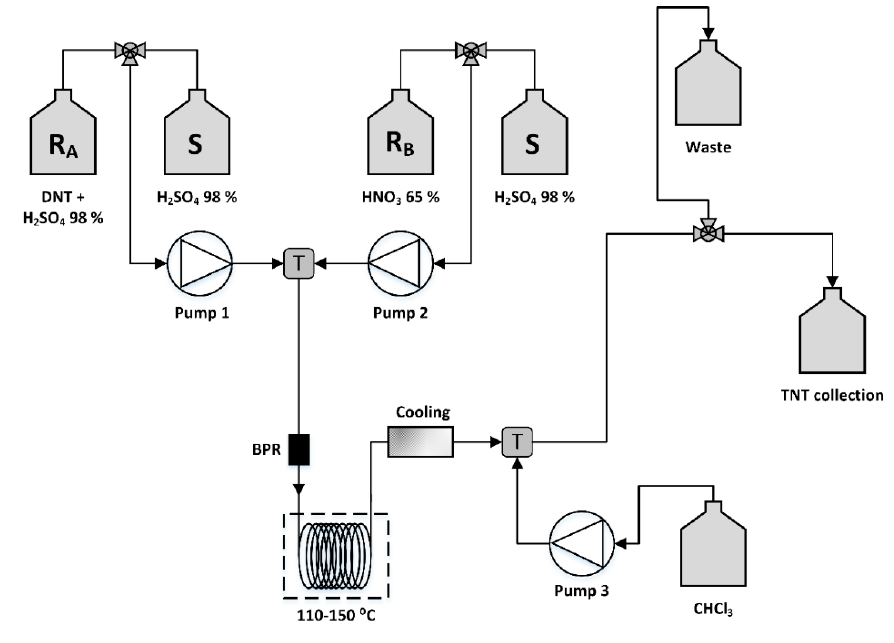
Figure 6. Configuration of the flow chemistry system used for TNT synthesis.